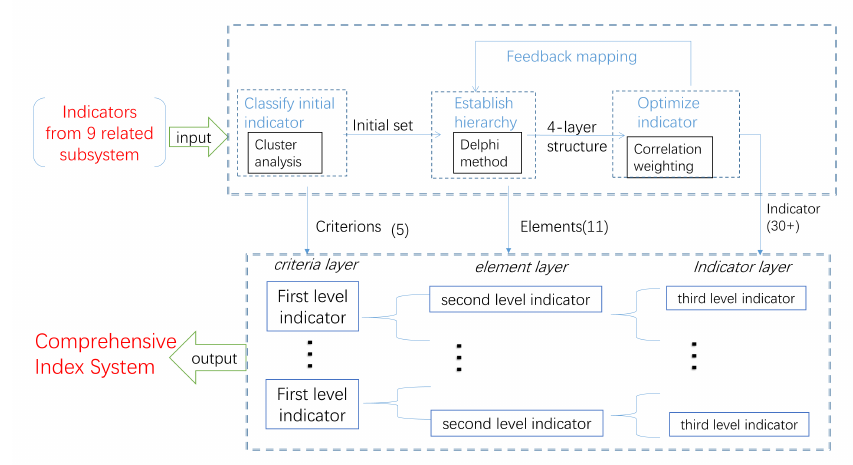
Figure 2. Construction solution of index